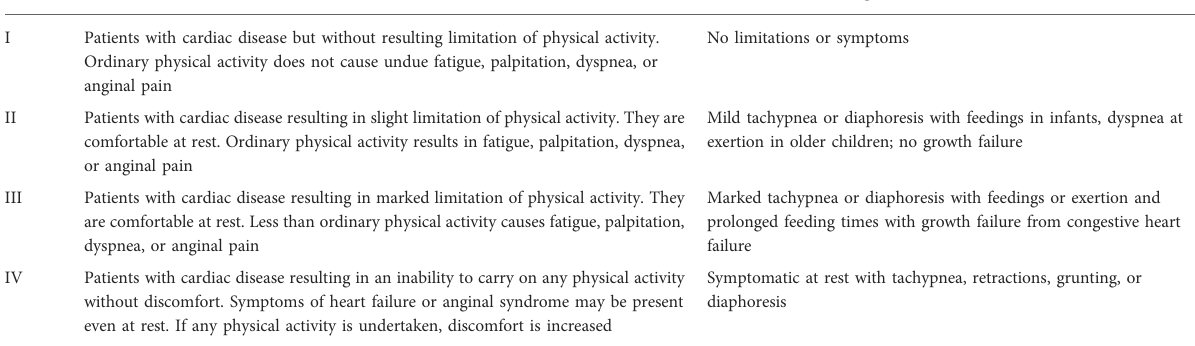
TABLE 1 Clinical cardiac function classi fi cation of heart